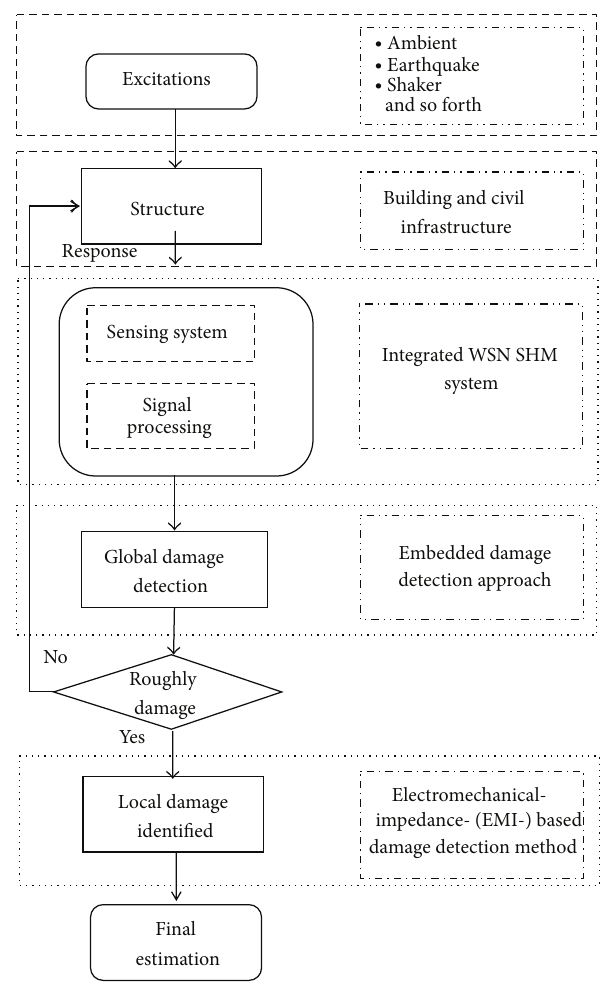
Figure 1: Global-local-integrated damage detection